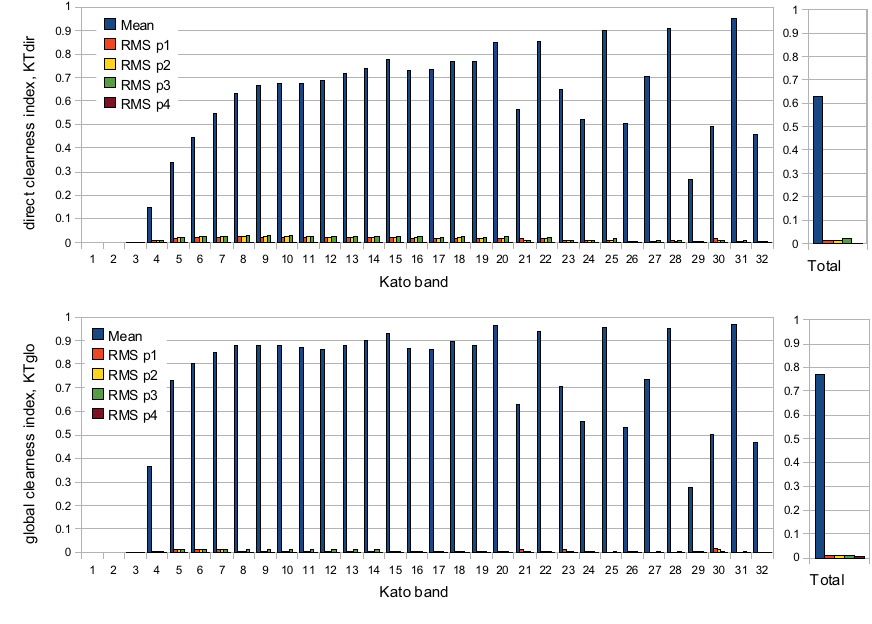
Figure 2. Mean KT and RMS for each parameterisation.